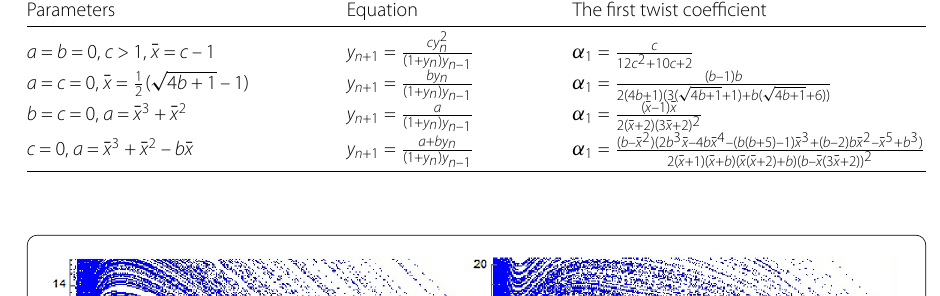
Table 1 The first twist coefficient for some values of a , b , c ≥ 0 Parameters Equation